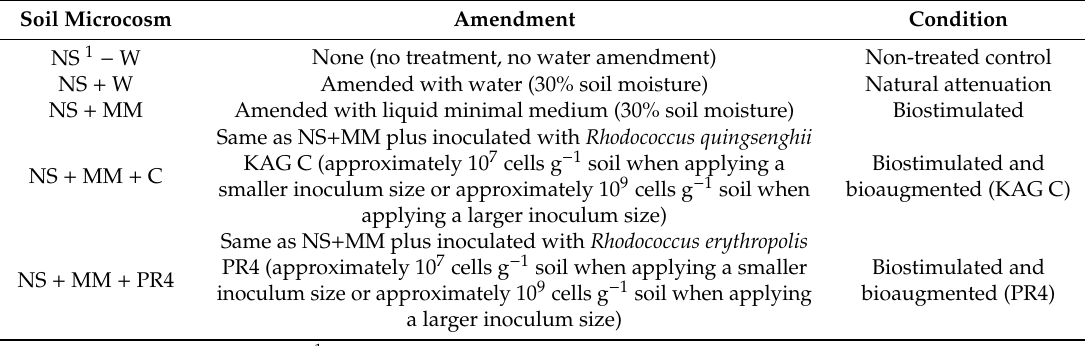
Table 1. Microcosm experimental